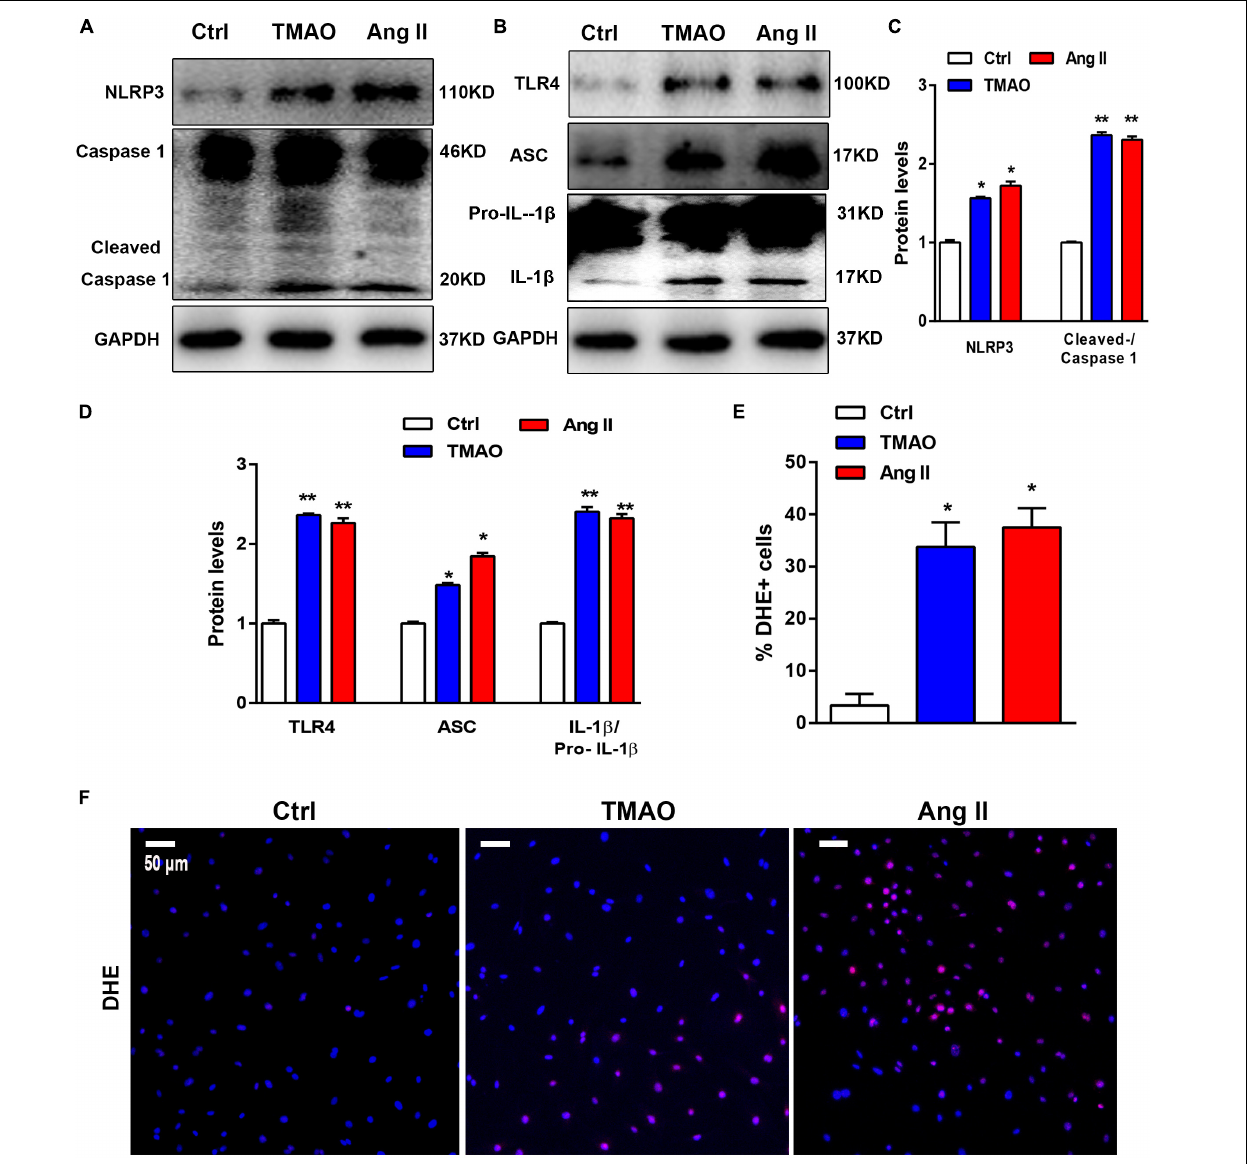
FIGURE 5 | TMAO induced NLRP3 inflammasome activation in vitro . (A,B) NLRP3, pro-IL-1 β ,IL-1 β , caspase-1, cleaved caspase-1, TLR4, and ASC protein expression levels were analyzed by western blotting and quantified (C,D) according to immunoblotting (the ratio of protein pixel density/GAPDH pixel density) after TMAO or Ang II treatment for 24 h. (E,F) Representative images and quantification of DHE staining (red) and DAPI (blue). Scale bar = 50 µ m. All data were analyzed at least three times. Mean ± SD. ∗ P < 0.05, ∗∗ P < 0.01, ∗∗∗ P < 0.001 (vs.